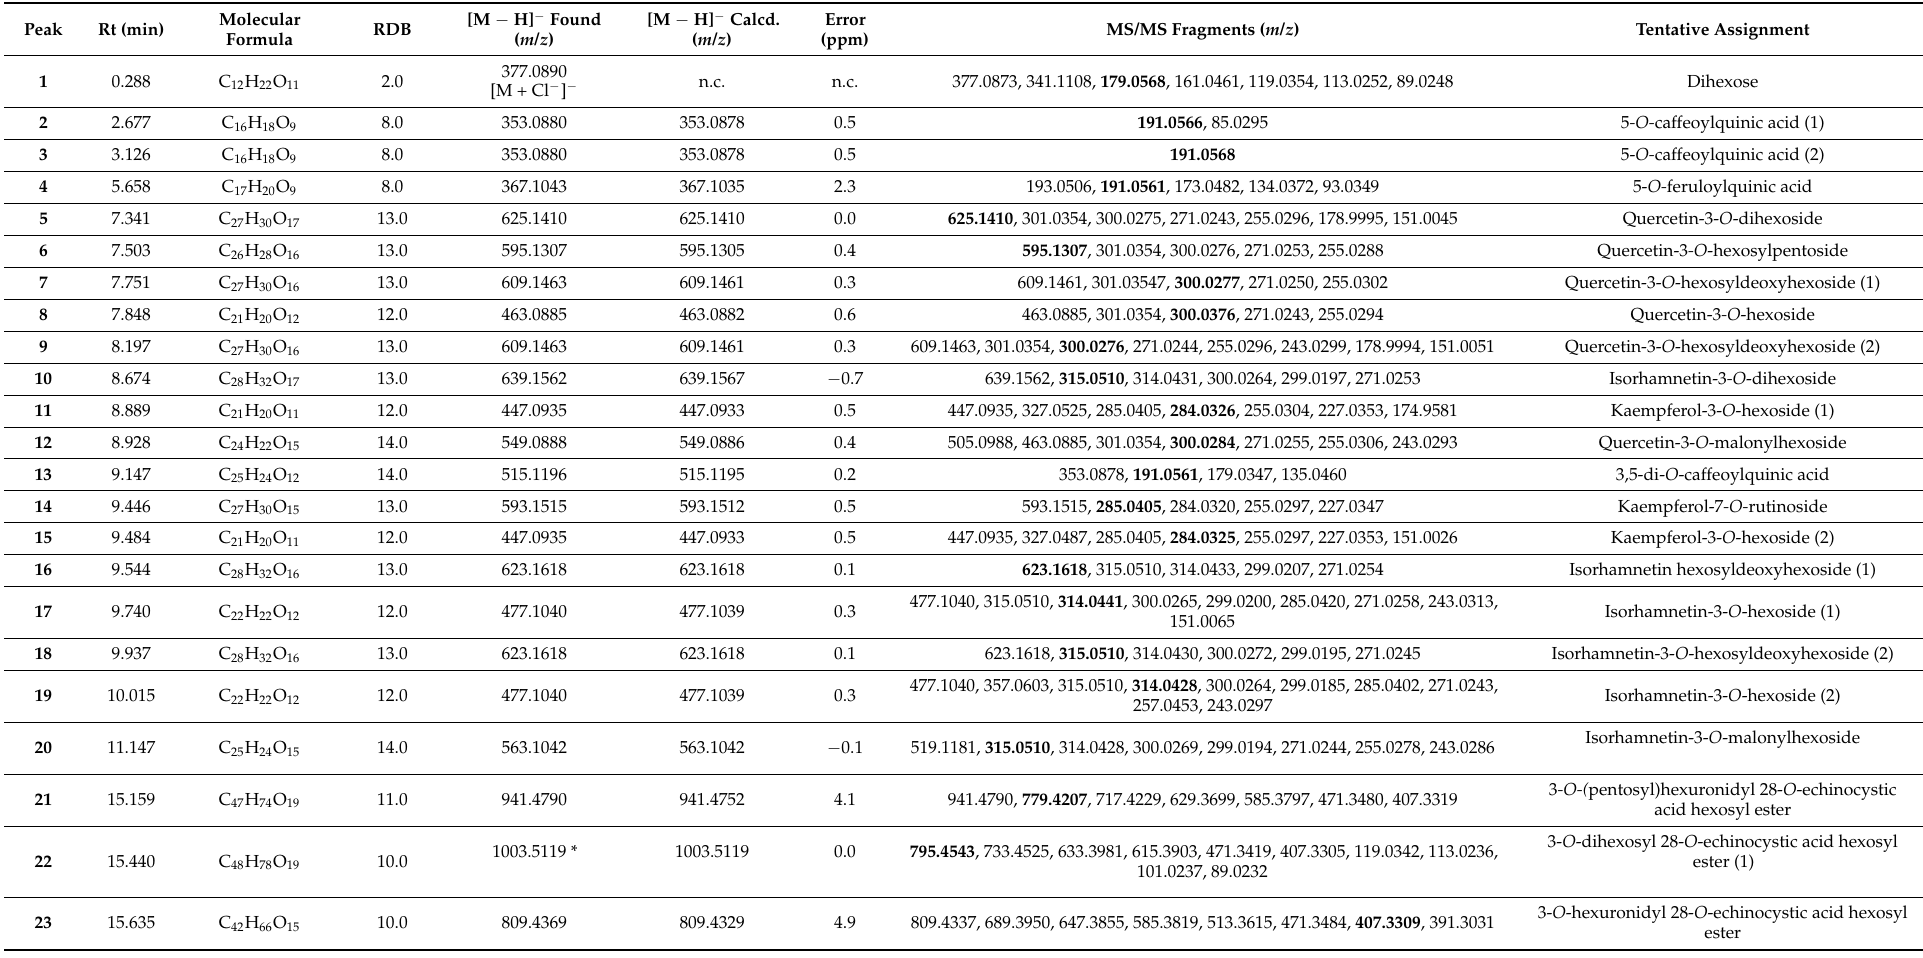
Table 1. Compounds tentatively identified in floret alcoholic extracts before in vitro digestion (base peaks in MS/MS experiments are reported in bold; RDB = Ring and Double Bonds, i.e., unsaturation degree; Rt = retention time). * Molecular ions detected as formate ([M + HCOO − ] − ) adducts. n.c. = not